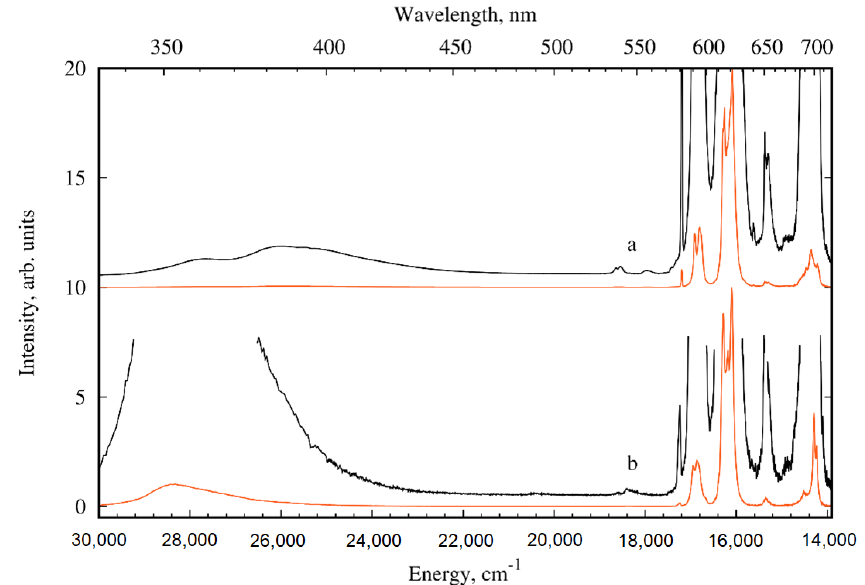
Figure 6. Luminescence spectra of 2 Eu ( a ) and 3 Eu ( b ) at λ ex = 280 nm and T = 300 K in solid state. The black curves show the spectra after magnification.